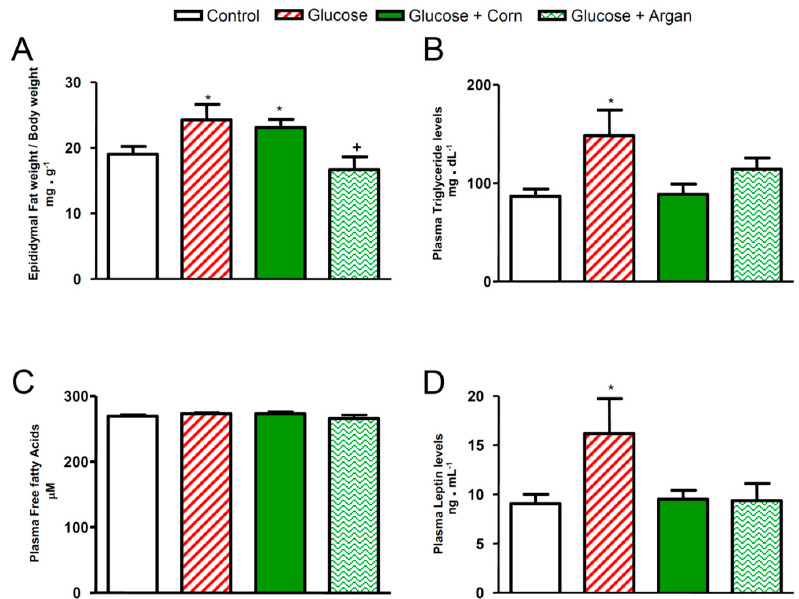
Figure 3. Effects of 12 weeks of glucose feeding combined or not with orally and daily administered (5 mL·kg − 1 ) corn oil or argan oil on ( A ) epididymal fat weight per body weight expressed in mg·g − 1 , ( B ) plasma triglyceride levels expressed in mg·dL − 1 , ( C ) plasma free fatty acids expressed in µM and ( D ) plasma leptin levels expressed in ng·mL − 1 . Values are the mean ± SEM of 7–10 rats per group. * p < 0.05 vs. control, + p < 0.05 vs. glucose + corn oil.